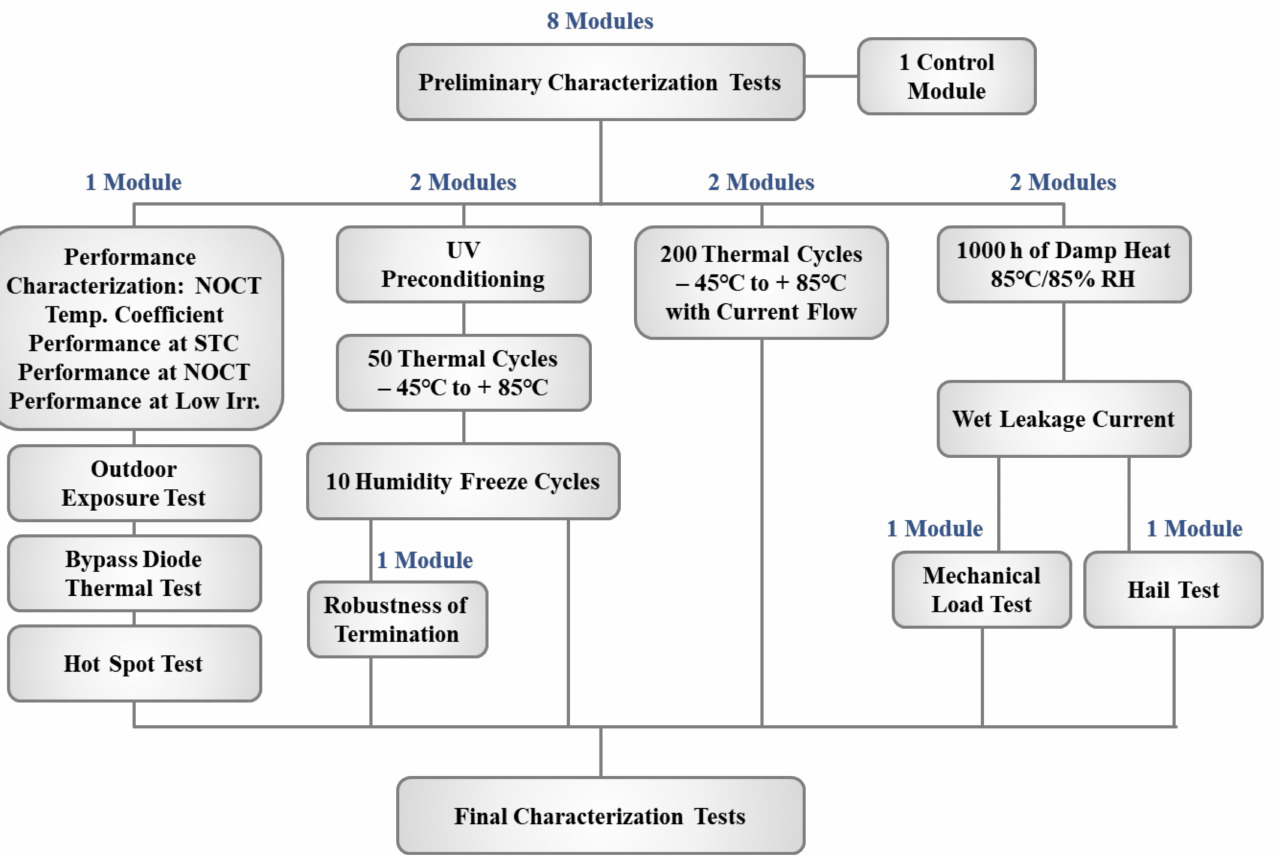
Figure 3. Test sequences of IEC 61215 qualification testing program for PV